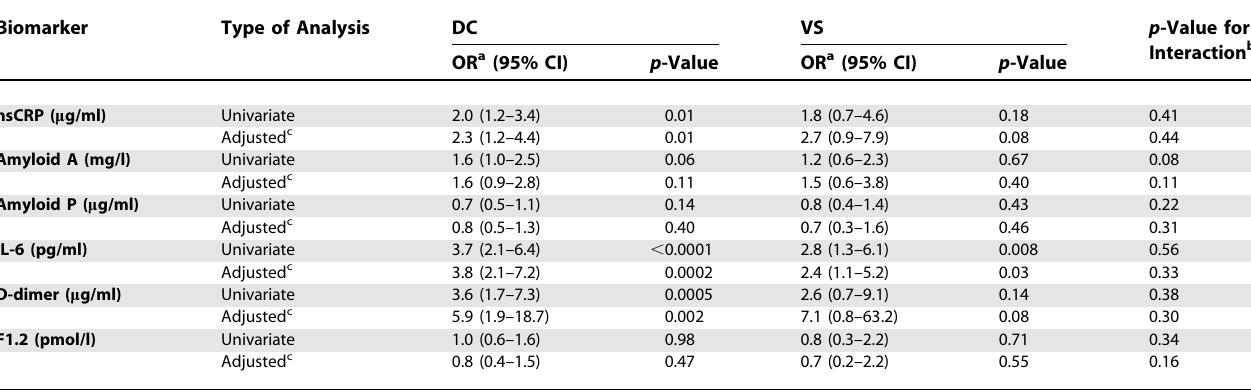
Table 4. Risk of Death Associated with Biomarker Levels at Study Entry for the Drug Conservation (DC) and Viral Suppression (VS) Treatment Groups